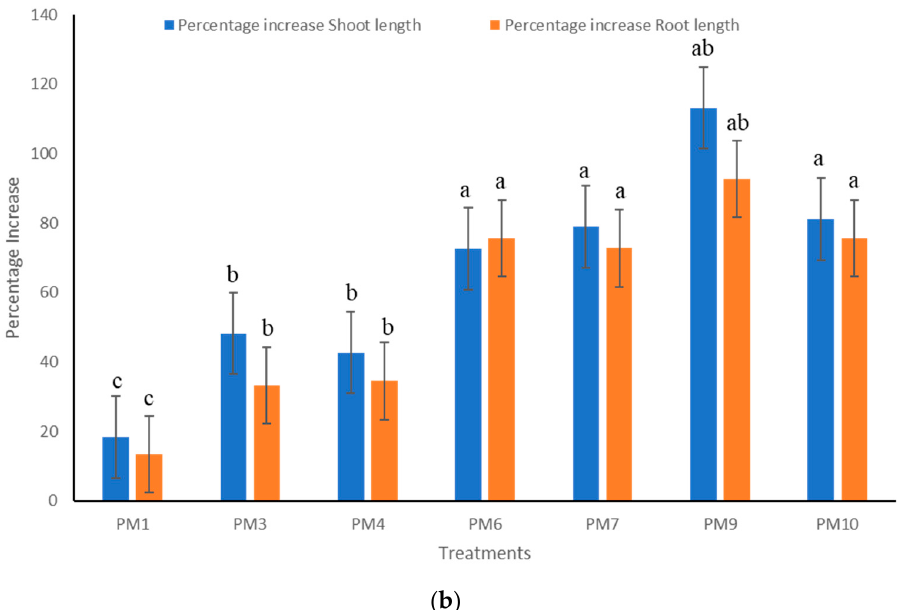
Figure 4. Impact of PGPR’s consortium on ( a ) root growth and ( b ) shoot and root length under field conditions. Different letters mean significant differences among categories ( p < 0.05). Error bars indicate ± SD. PM1—Control, PM3—Benomyl, PM4—Captan, PM6—Recommended dose of NPK, PM7—Soil fumigation with MeBr (425 kg/ha broadcast 98:2 MeBr:chloropicrin), PM9—PGPR’s